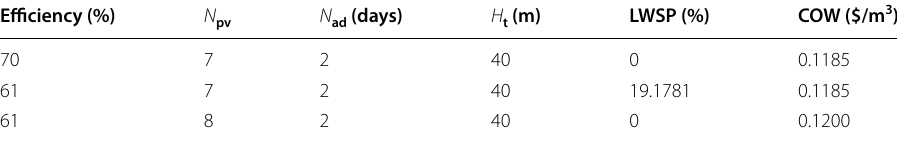
Table 10 Influence of the pump efficiency variation on the system reliability and configuration Efficiency (%) N pv N ad (days) H t (m) LWSP (%) COW ($/m 3 ) 70 7 2